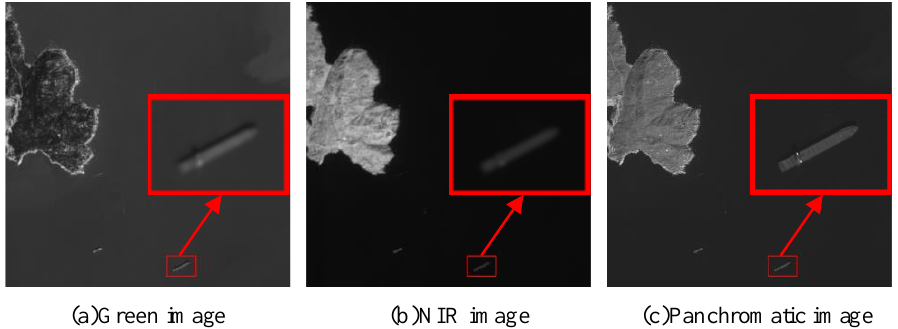
Figure 2. Three images of different wavebands and resolutions. ( a , b ) are 512 × 512 pixels and have a spatial resolution of 8 m. ( c ) is 2048 × 2048 pixels and has a spatial resolution of 2 m. All images are scaled to the same size for